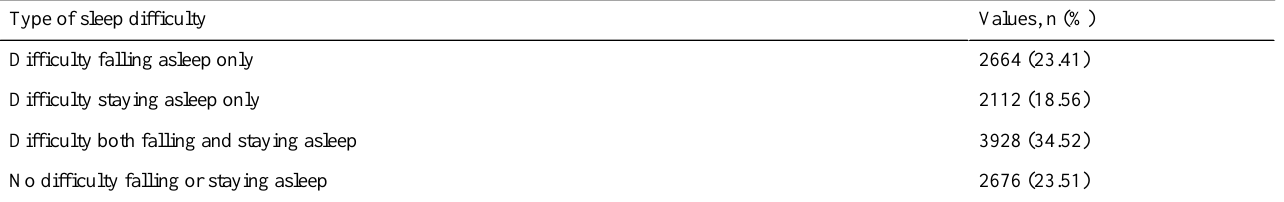
Table 3. Self-reported sleep difficulties in Calm subscribers